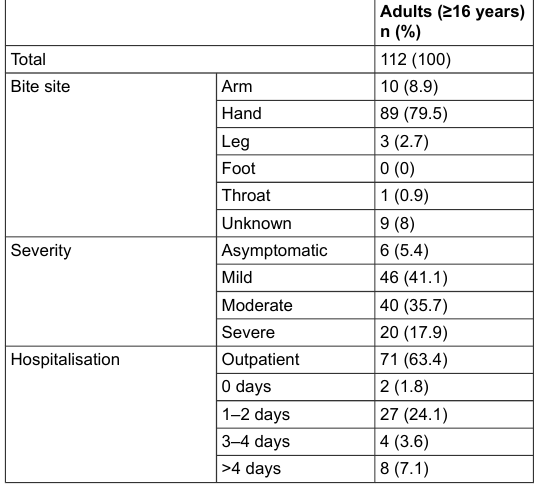
Table 2: Clinical characteristics and duration of hospitalisation of patients with feedback (n = 112).